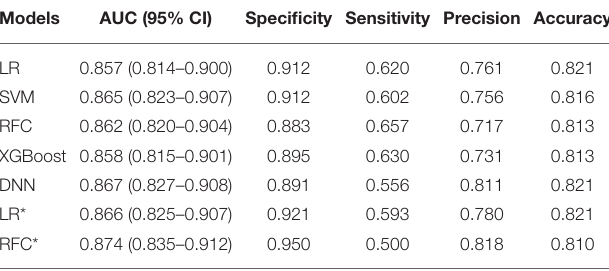
TABLE 3 | Scores for each model in the testing set.